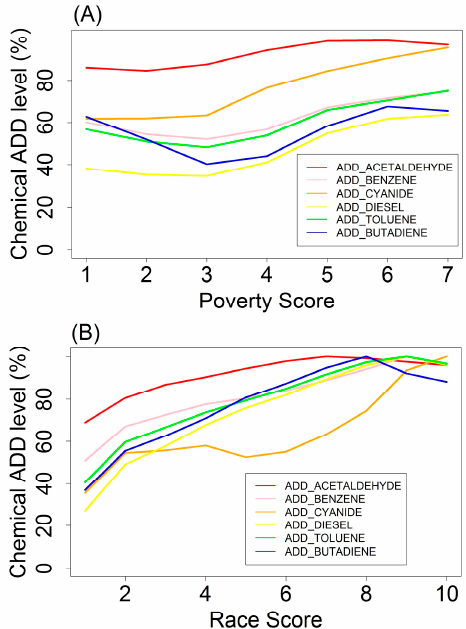
Figure 1. Single-chemical Average Daily Dose (ADD) level (%) associated with EJ scores. ( A ) Poverty Score; ( B ) Race Score; ( B ) Race Score.